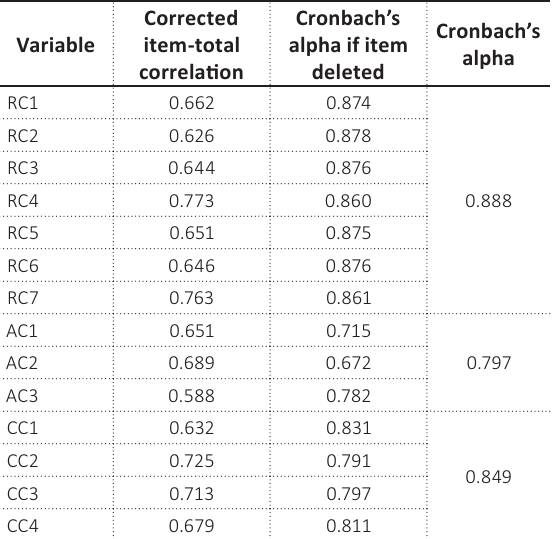
Table 2 (cont.). Analysis of reliability